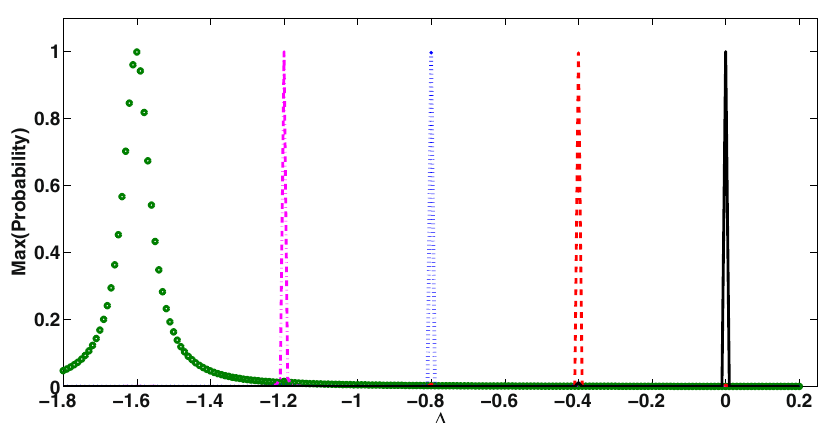
Figure 5. Maximum probability of detecting quantum states | p , q 〉 as a function of Δ for χ = 0.2 and J = 0.05 from the initial state |5, 0 〉 . Note that, complete switching occurs from |5, 0 〉 to |41 〉 (circle), |32 〉 (dot-dashed), |23 〉 (dotted), |14 〉 (dashed) and |05 〉 (continuous) at Δ = − 8 χ , Δ = − 6 χ , Δ = − 4 χ , Δ = − 2 χ and Δ = 0 respectively satisfying the relation Eq. (10). The system parameters are expressed in the unit of ω 1